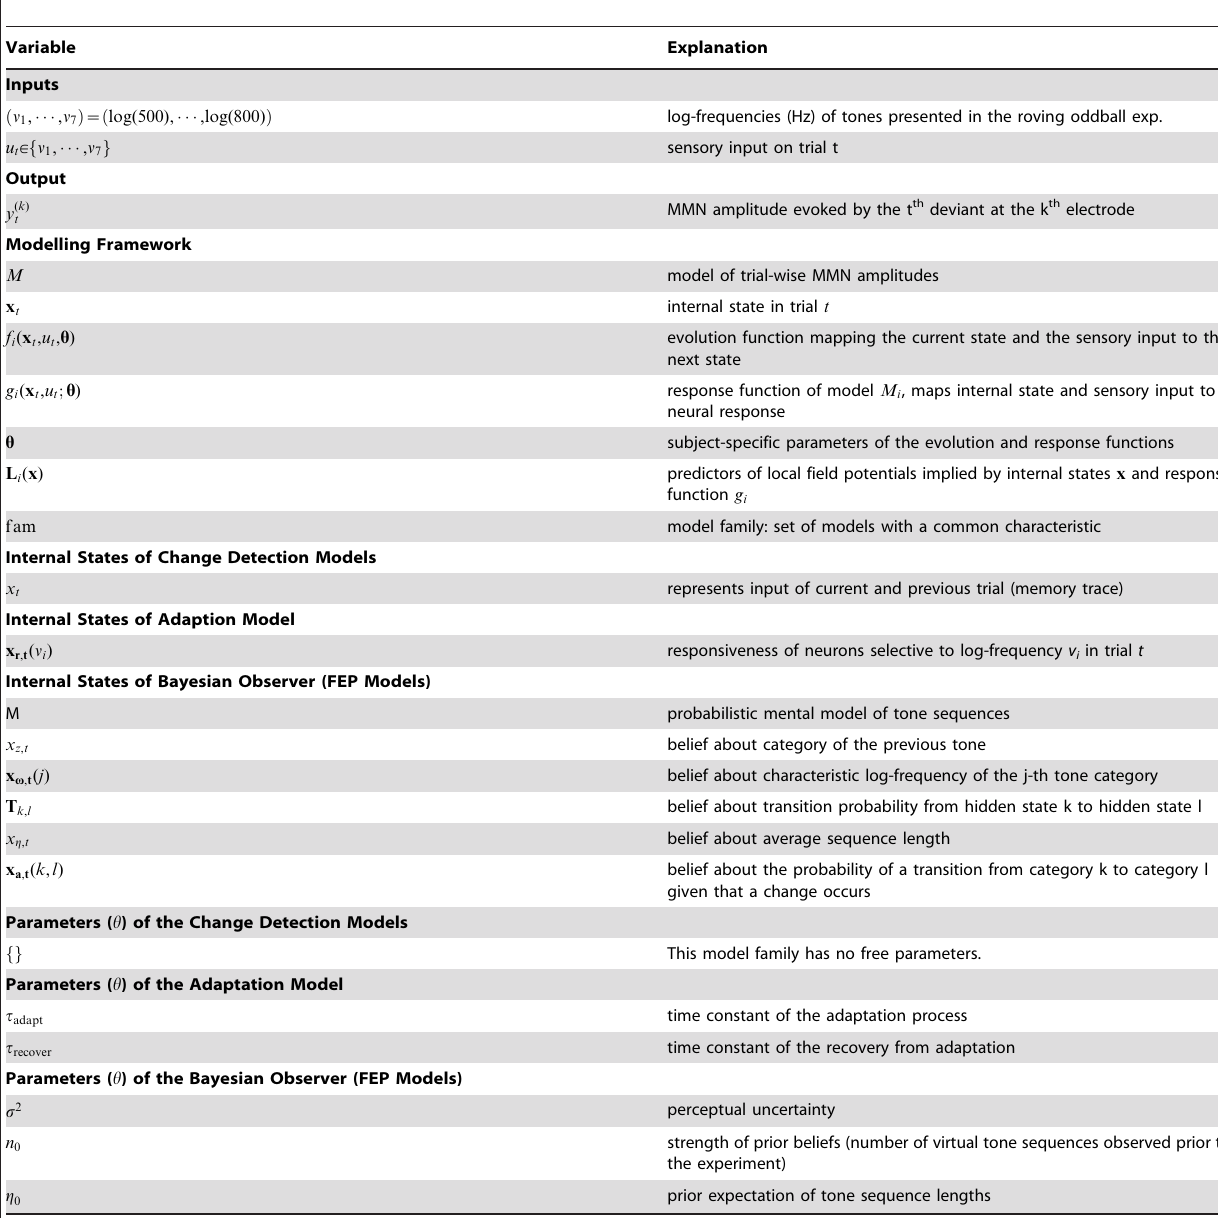
Table 2. Explanation of the variables in our computational models of trial-wise MMN amplitudes.